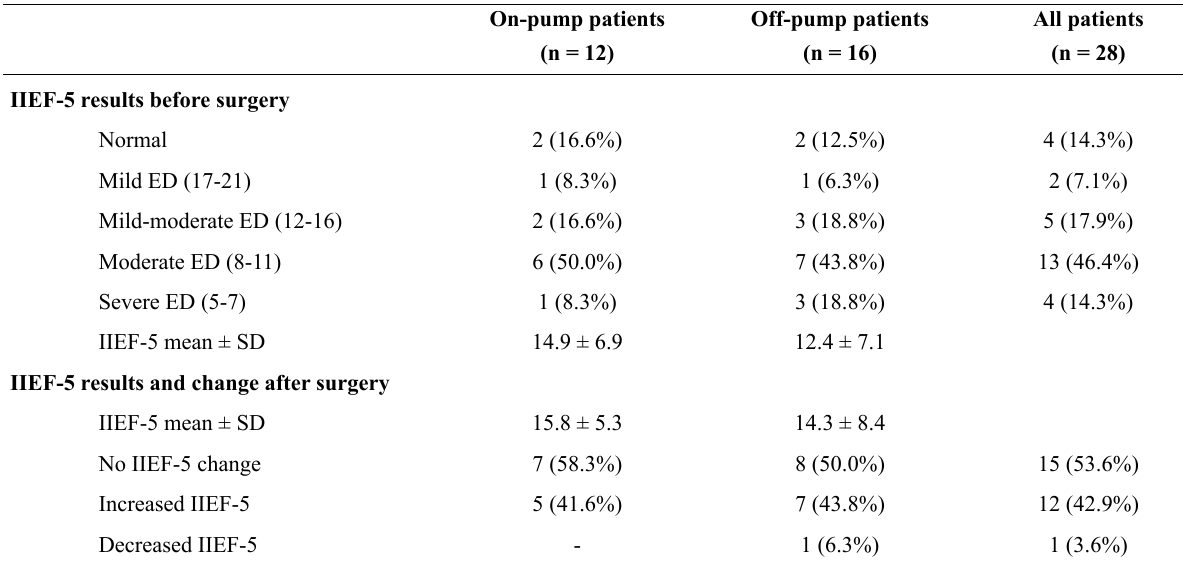
Table 2 - Comparison between on-pump and off-pump patients.